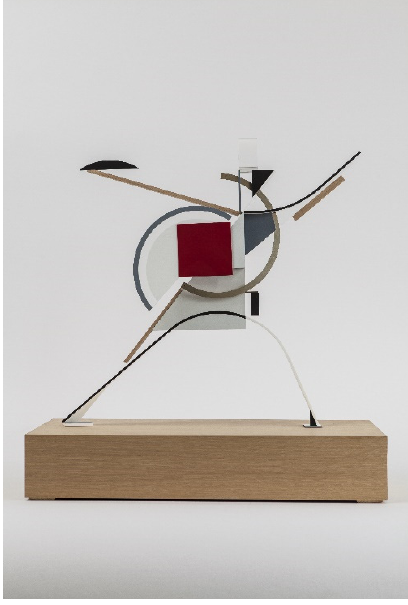
Figure 23. Model after El Lissitzky, ‘The New Man’, 1923, construction by Henry Milner, 2009. Van Abbemuseum. Photo: Perry van Duijnhoven.